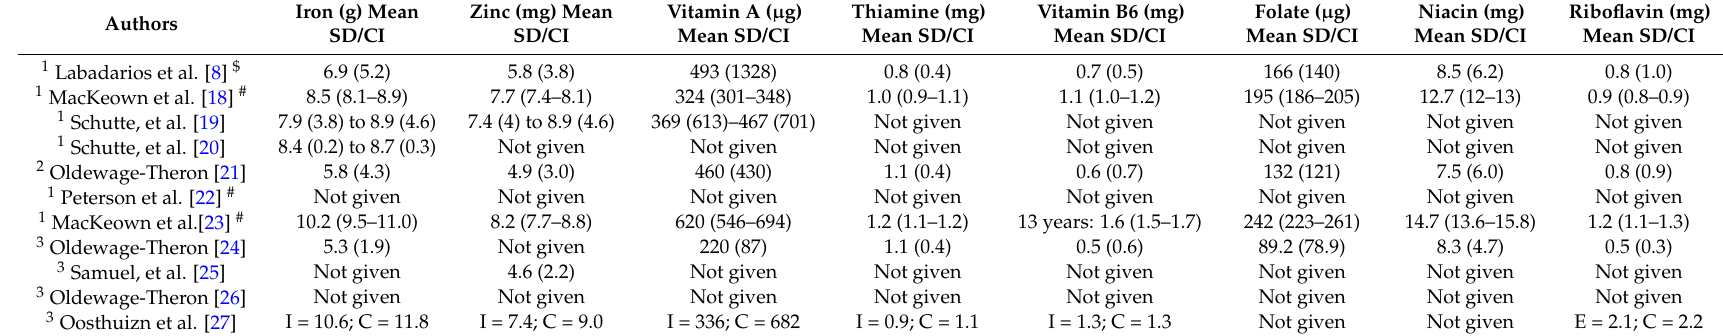
Table 2. Dietary intake studies from 2000 onwards that included daily micronutrient data from children between the ages of 6 and 15